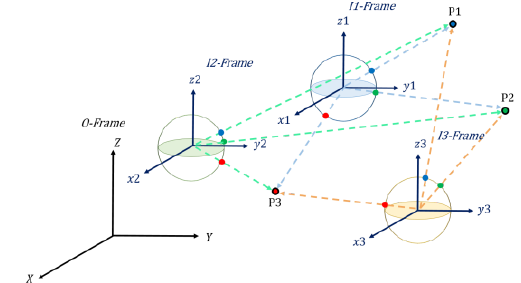
Figure 3. Concept of multi-station network adjustment of